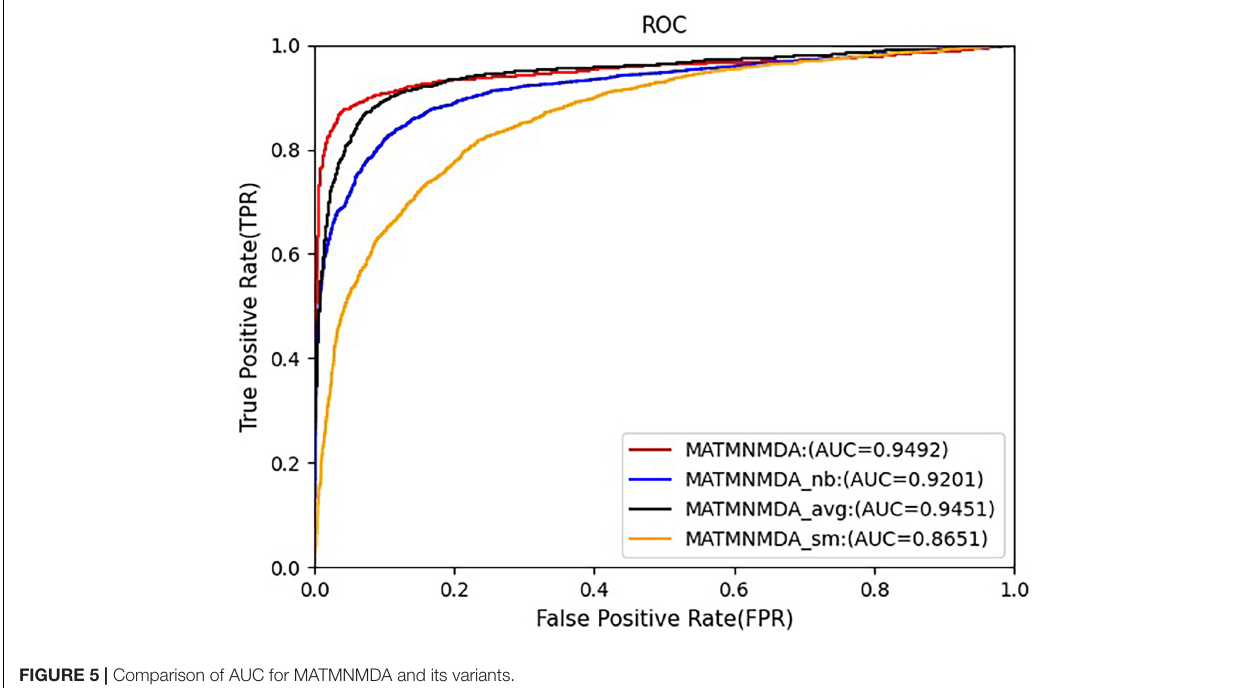
FIGURE 5 | Comparison of AUC for MATMNMDA and its variants.